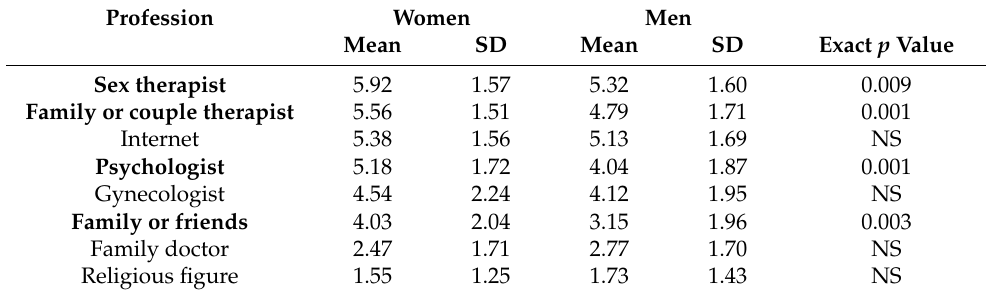
Table 4. Appropriate treatment source for HSSD—gender differences (scale 1–7, 7 very appropriate).